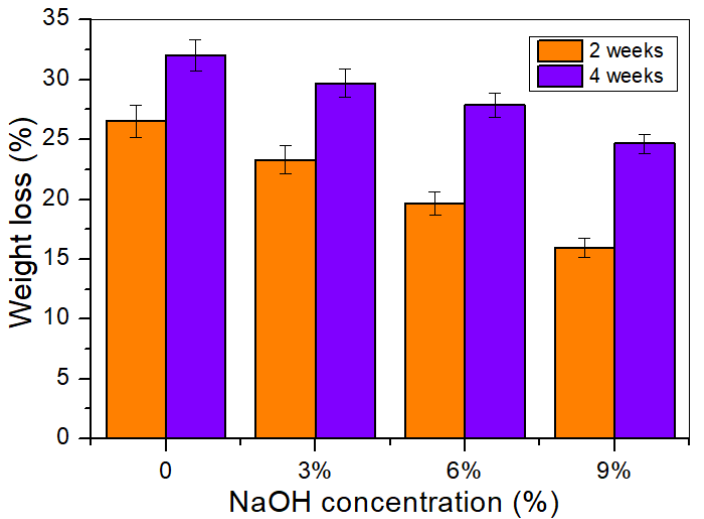
Figure 14. Weight loss of untreated and treated TPCS/PW/CCF composites after soil burial for two and four weeks.